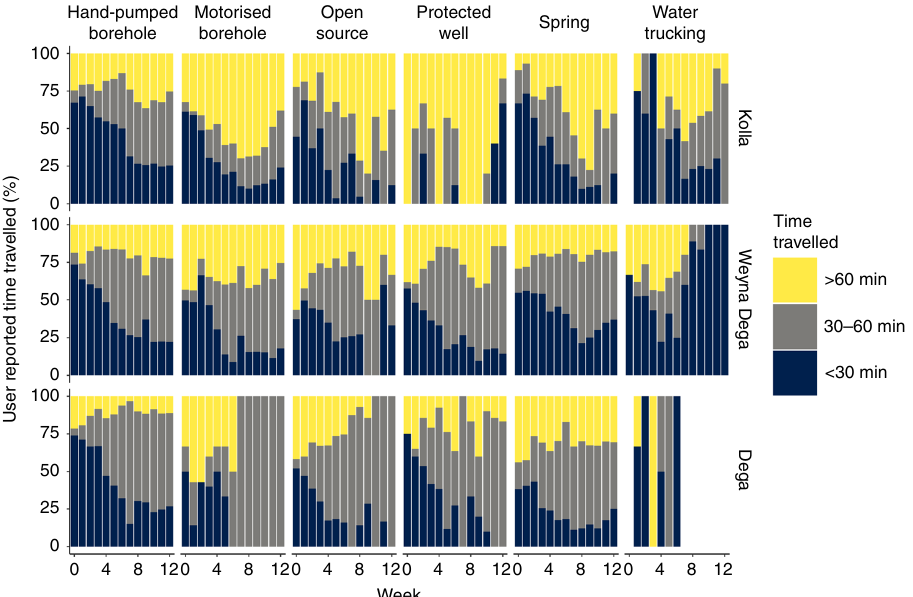
Fig. 5 Reported travel times by water source type. Travel times to access water in each of Ethiopia ’ s three main altitude zones for each water source type. Supplementary Figure 8 provides details on the numbers of each source type visited in each region and for which estimated collection times are available. Note that there were only three sites that were reliant on water trucking in the Dega during the monitoring period, these sites were not monitored consistently leading to gaps in the time